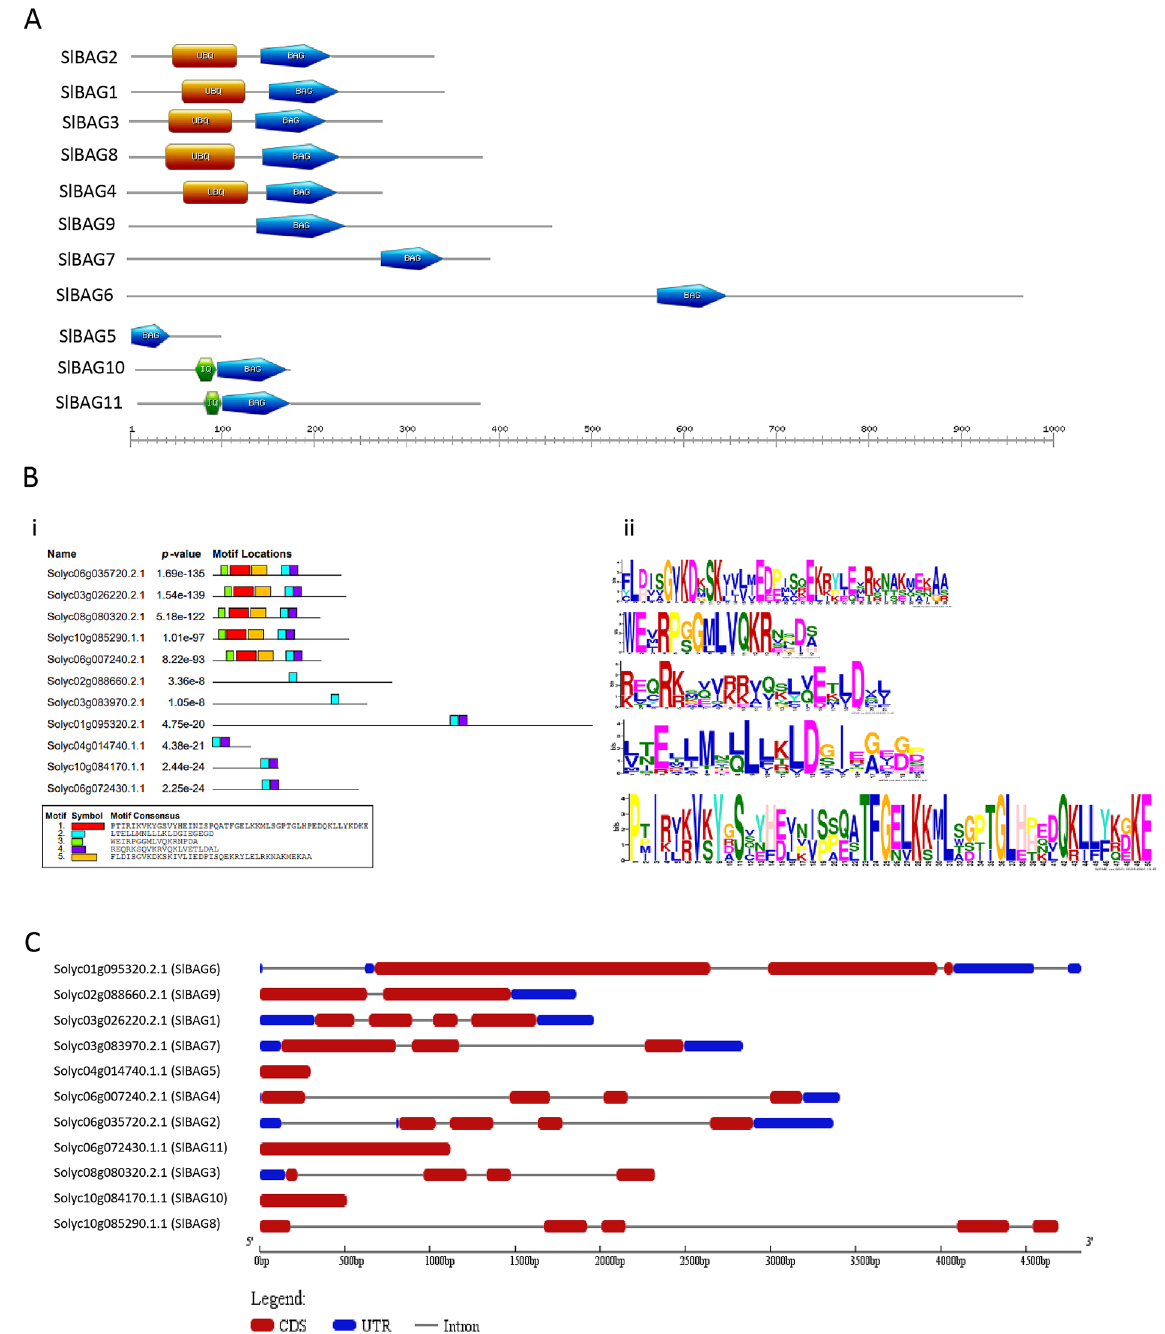
Figure 1. Gene architecture of SlBAG family of tomato. ( A ) Domain analysis; The SlBAG protein length can be estimated using the scale at the bottom. ( B ) (i) 5 conserved motifs, identified using MEME Suite 5.4.1 (https:// meme- suite. org/ meme/); Each motif is displayed in different color (ii) Sequence logos of conserved motifs. The x-axis denotes the width of the motif, and y-axis represents the frequency of each letter ( C ) Exon–Intron structure of SlBAG genes. Red and blue rectangles represent the CDS and UTR regions respectively, and black line represents intron. The CDS, UTR and intron length of SlBAGs has been displayed